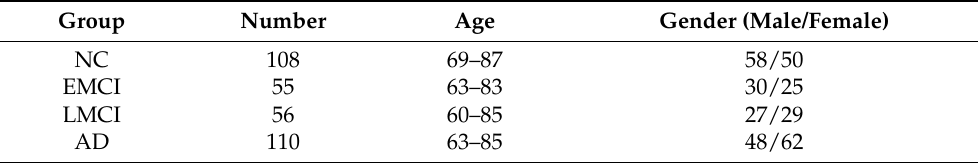
Table 1. Experimental data details.